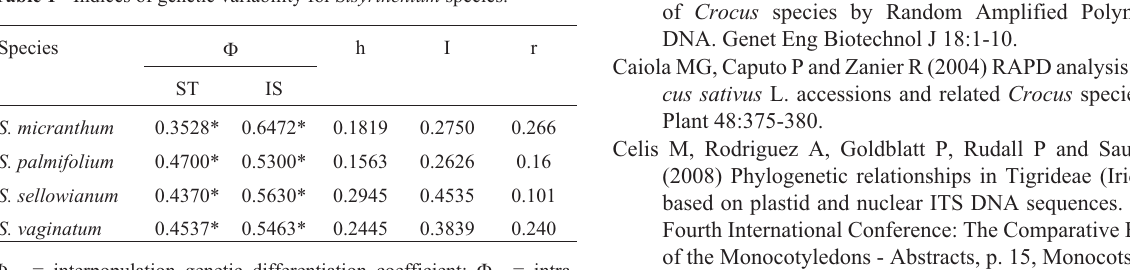
Table 1 - Indices of genetic variability for Sisyrinchium